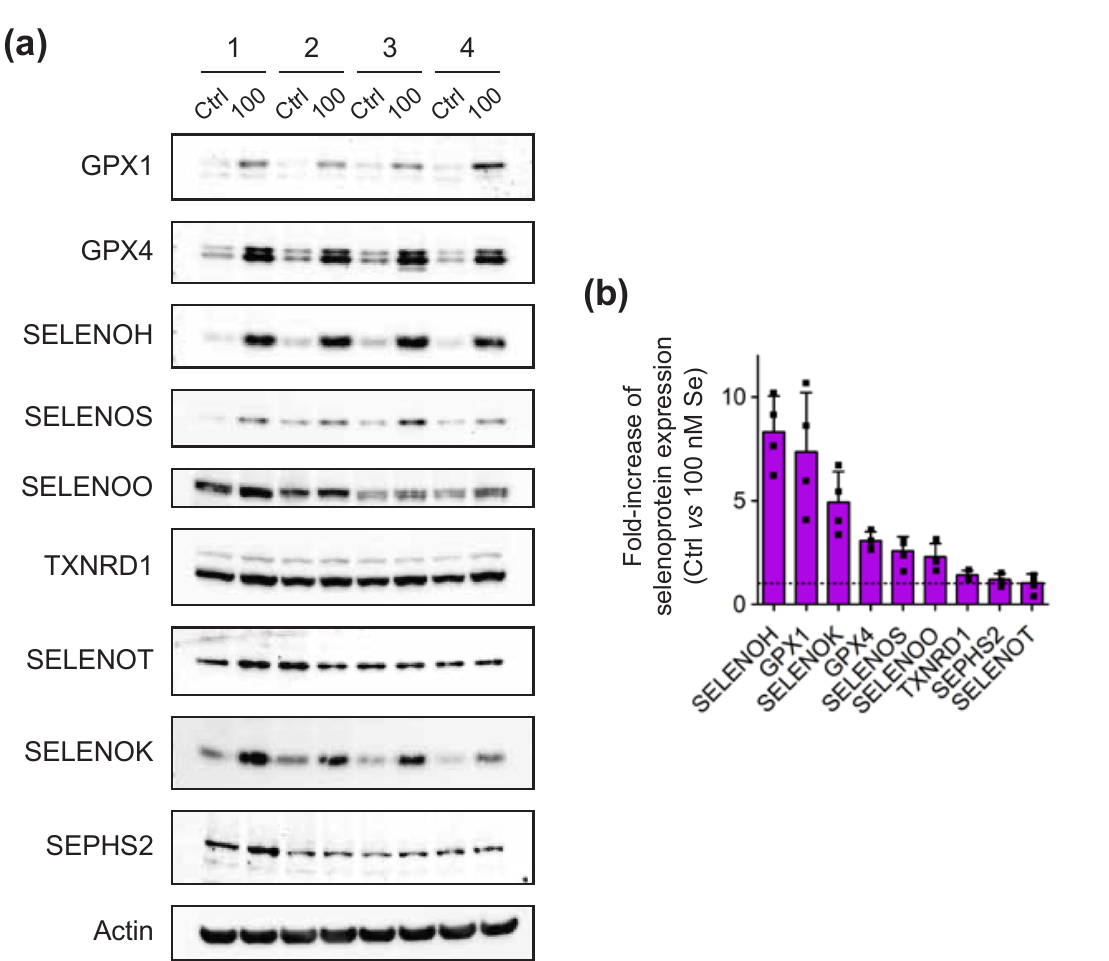
Figure 5. Analysis of selenoprotein expression in CD4 T cells isolated from four different donors in control (Ctrl) and selenium-supplemented (100 nM) conditions over three days. The results from a representative experiment are shown in ( a ). The values are given in Table S4. ( b ) The fold-increase in expression of each selenoprotein in response to selenium supplementation was calculated between the value at 100 nM over that at Ctrl. The average value ( ± standard deviation) of the four donors was represented by a bar, but the individual value of each donor was indicated by a square. The dotted line represents a fold-increase value of one.